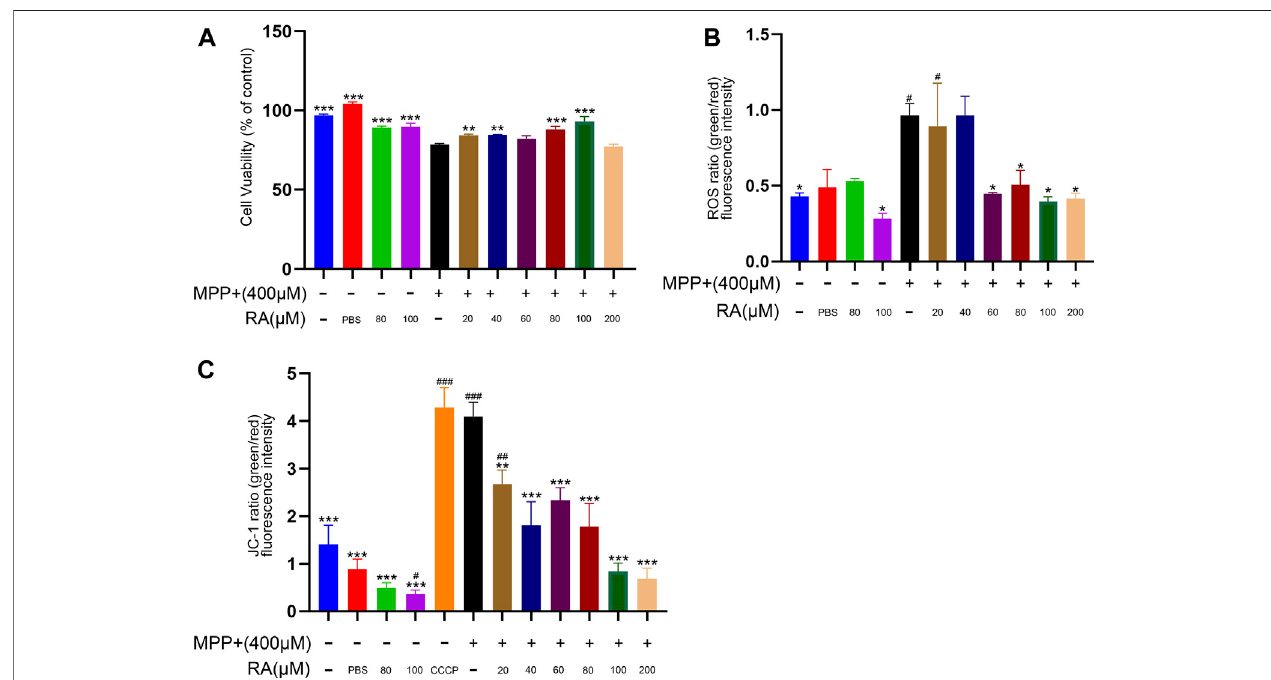
FIGURE 4 | RA protected SHSY5Y cells against MPP+-induced loss of cell viability and oxidative stress. (A) SH-SY5Y cells viability was measured by CCK-8 after being incubated with various concentrations of RA. MPP + resulted signi fi cantly decrease in cell viability, and pre-injection with RA in a dose-dependent manner signi fi cantlyreducedtheMPP + -inducedreductionincellviability.One-wayanalysisofANOVAwithTukey ’ stestwasused.Dataareexpressedasmean±SD.N=3cells pergroup,* p < 0.05,** p < 0.01,*** p < 0.001whencomparedwiththeMPP + group. (B) ROSwasutilizedtoevaluatetheoxidativestressoftheSH-SY5Ycellsafter RA incubation. MPP + caused increased the green/red fl uorescence intensity in the SH-SY5Y cells, and RA signi fi cantly reversed these changes in a